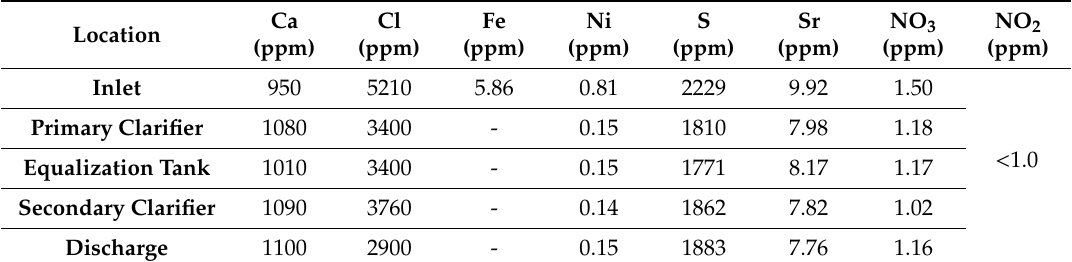
Table 2. Concentration of Select Species in flue gas desulfurization (FGD) Wastewater in parts per million by mass